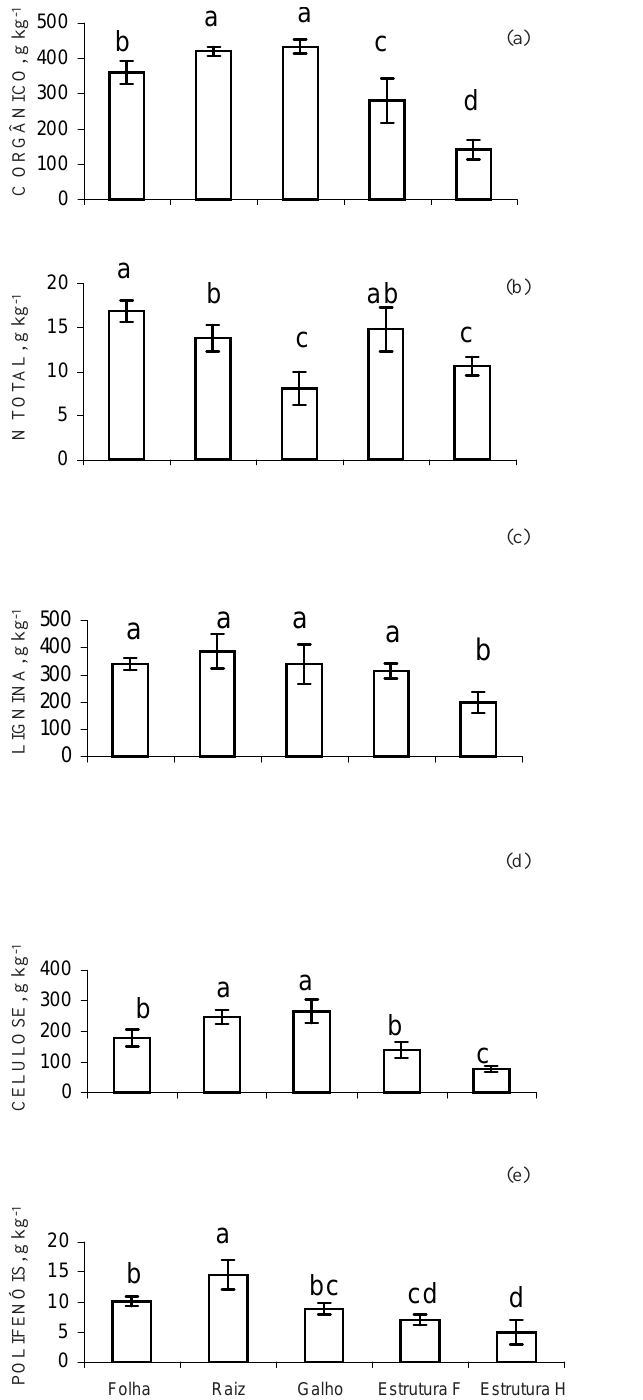
Estrutura F: mistura de material mais fragmentado, como fo- lhas, raízes e gravetos; estrutura H matéria orgânica menor que